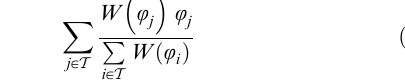
transmission events over time. Increasing cross-reactive immunity (from left to right) decreases the average replication rate of transmitted strains. Figure S2 Effects of parameter variations on the replication rate of transmitted strains. Effect of the initial replication rate Q 0 (x- axis) on the average transmitted replication rate for different values of A) mutation rate m , B) mutation width w of the replication rate, C) maximum proliferation rate of immune cells c max , and D) maximum killing rate of immune cells s max . Different parameter values are shown using different colour symbols (see the box in each panel) and the default case is in black. Found at: doi:10.1371/journal.pcbi.1000565.s002 (0.52 MB EPS) Text S1 Details about the simulations. This text file gives further details about the simulations and the statistical tests used in Table 2. Found at: doi:10.1371/journal.pcbi.1000565.s003 (0.08 MB PDF) Text S2 Additional results. We discuss the effect on life-history traits of variations of the initial value of immune cells and infected cells, of the probability of virulence and of the effect of a saturation term for the description of lymphocyte proliferation rate function. Found at: doi:10.1371/journal.pcbi.1000565.s004 (0.08 MB